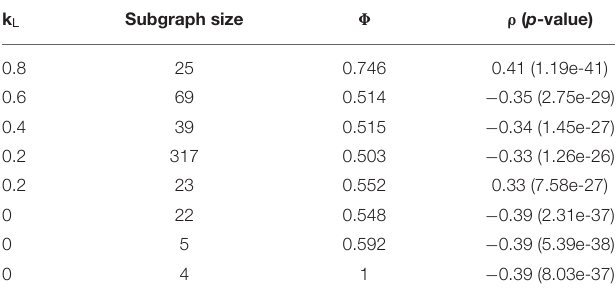
TABLE 6 | Effect of Louvain weights on top subgraphs produced by the hybrid